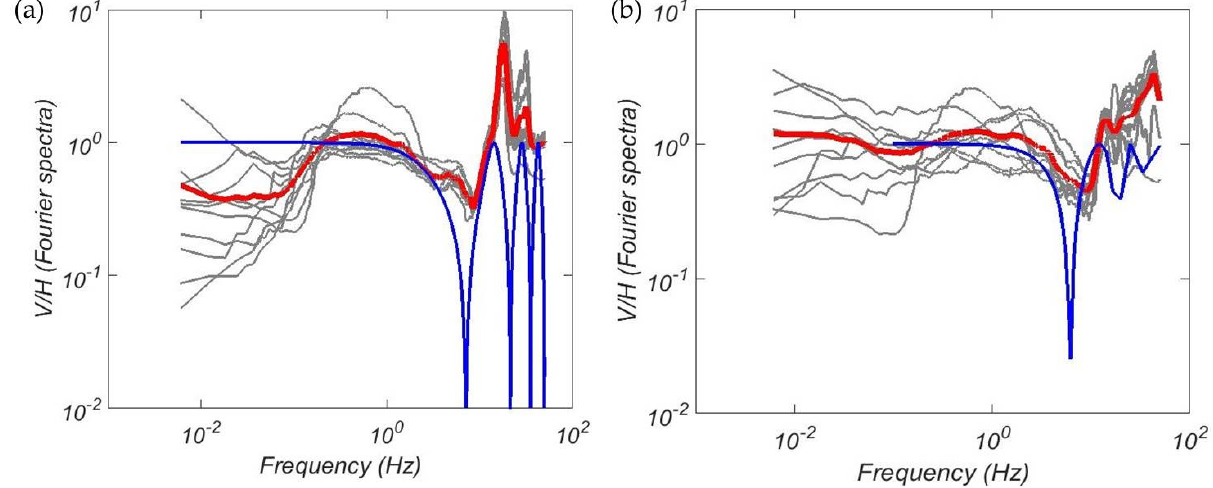
Figure 13. V/H spectral ratio curves of 10 local earthquake signals obtained at St3 site ( a ), at Typ2 site ( b ) and corresponding theoretical reduction spectra due to the water column above the sites. Gray lines—the earthquakes FFT spectral ratio curves; red line—the average curve for the FFT spectral ratios; blue line—the theoretical reduction spectra.